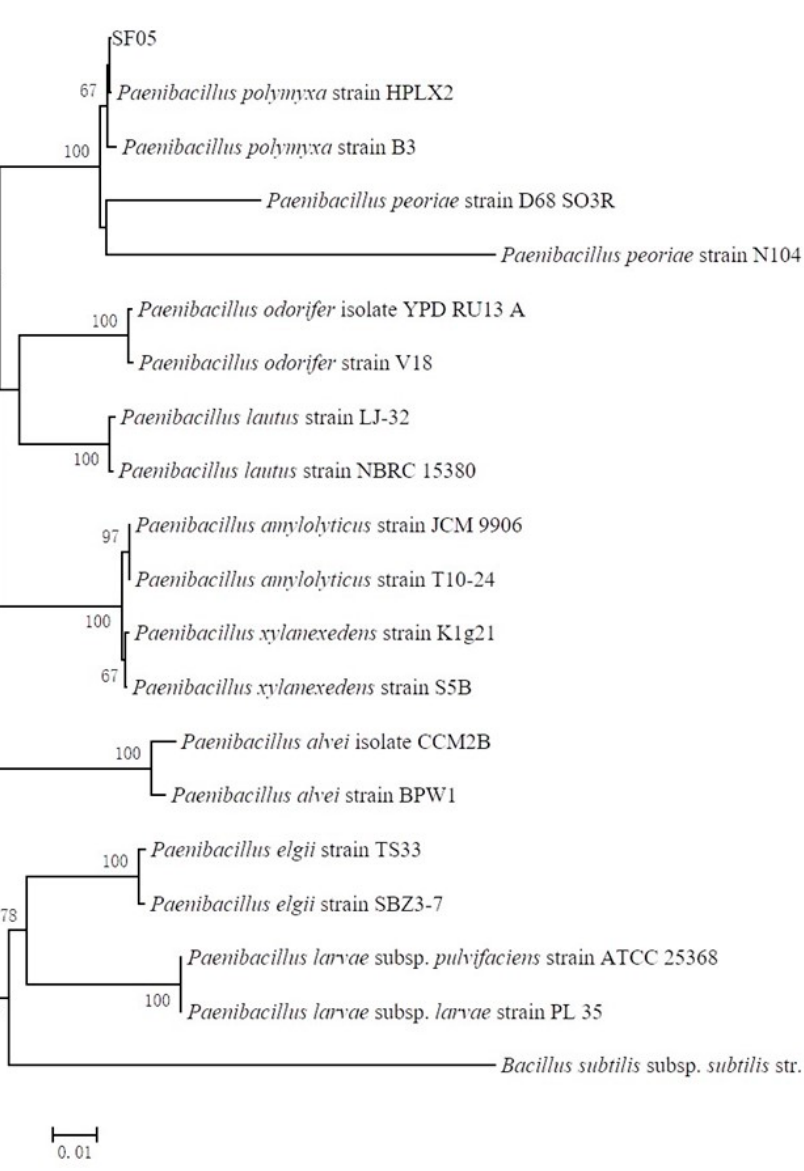
Figure 1. Phylogenetic tree constructed based on sequences of 16S rDNA of Paenibacillus genus. The phylogenetic tree was constructed by the neighbor joining method and the sequence of 16S rDNA of Bacillus subtilis subsp. subtilis str. 168 was used as root. Numbers nearby the branches indicate the percentage of support for 1000 bootstrap resampling analysis. The length of 0.01 was the genetic distance. Biological characteristics of SF05 determined by SPI 20 E showed that P. polymyxa